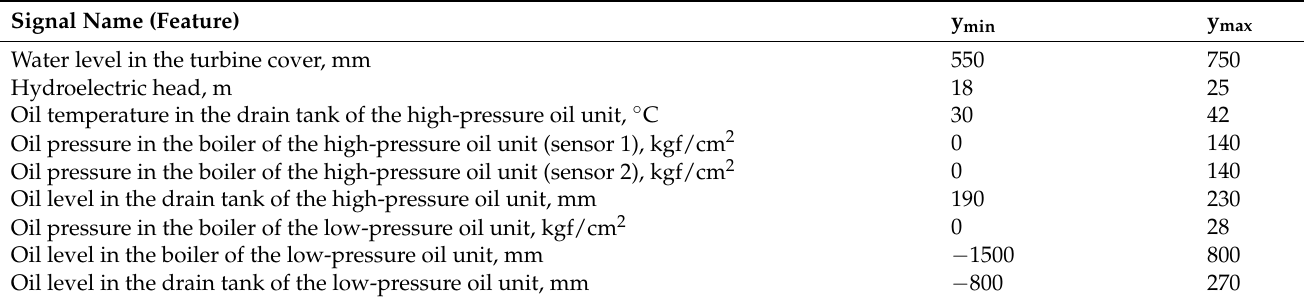
Table 1. Values of warning alarms for the parameters of the technical state of the automatic turbine control system.